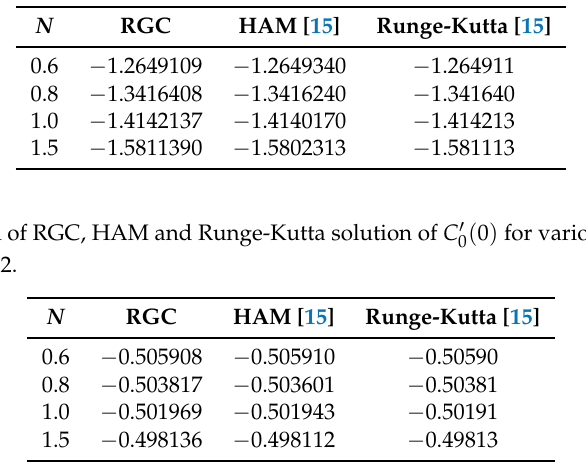
( 0 ) for various values of N while 1